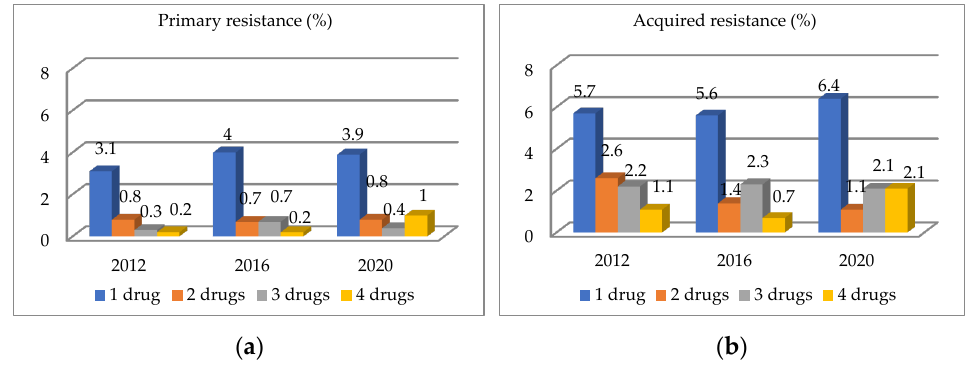
Figure 2. Resistance to one or more drugs among newly diagnosed ( a ) and previously treated ( b ) patients in Poland in 2012, 2016, and 2022.